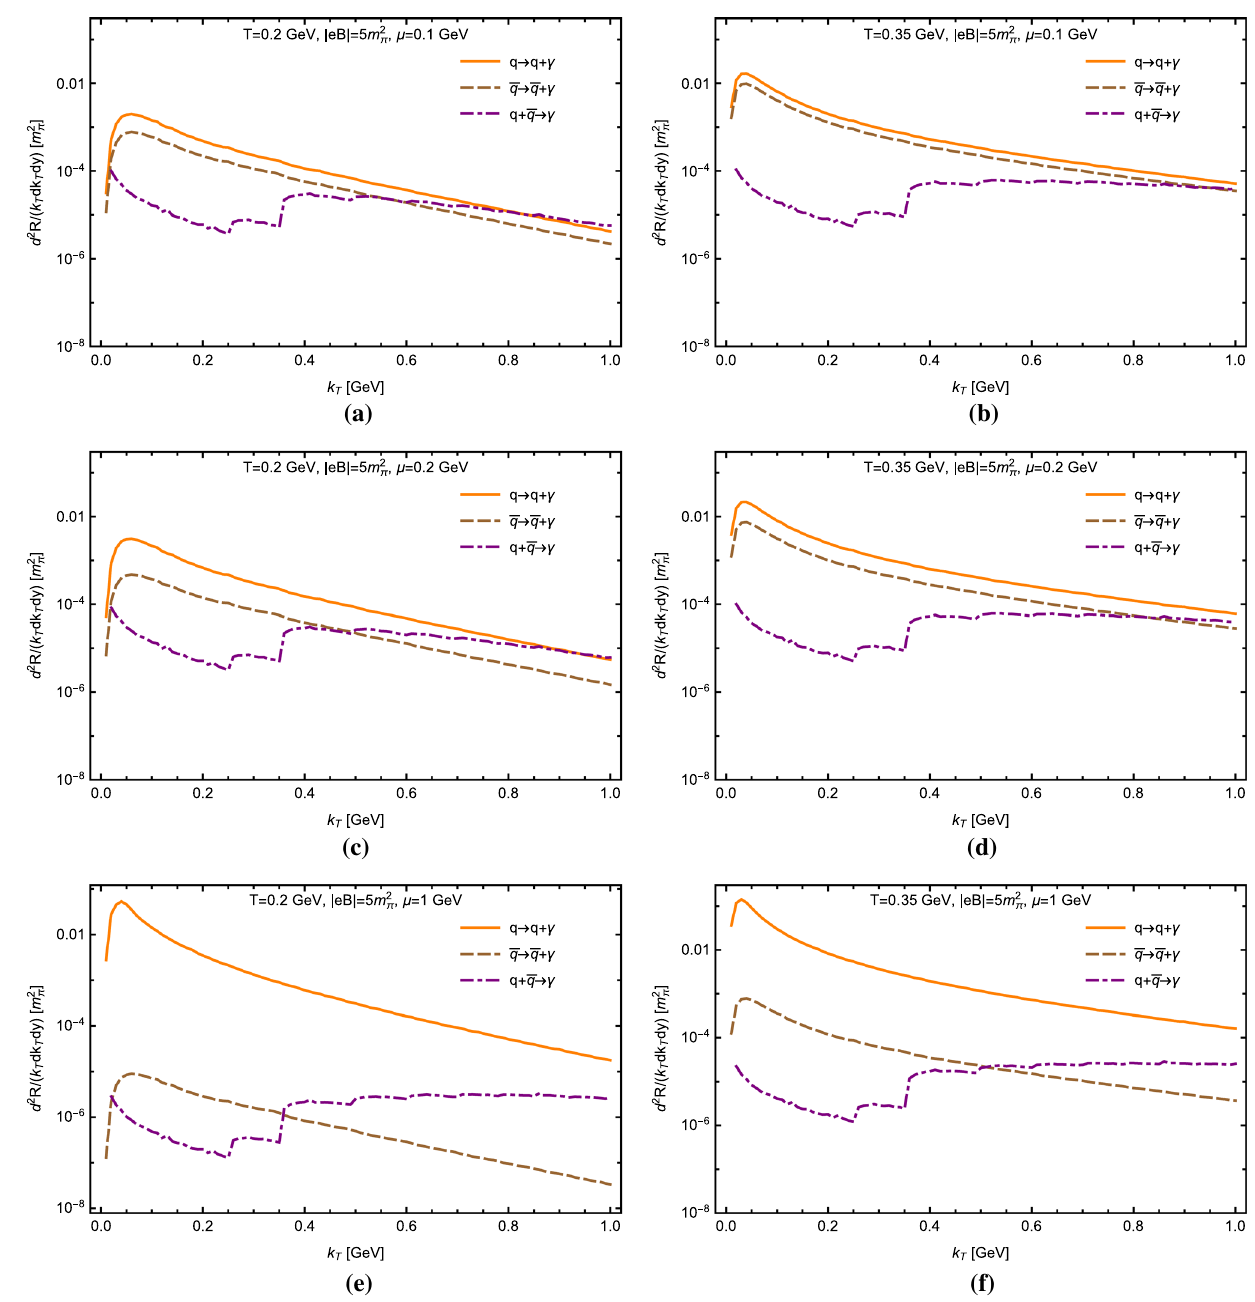
Fig. 4 Partial contributions of different types of processes, i.e., q → q + γ (orange lines), ¯ q → ¯ q + γ (brown dashed lines), and q + ¯ q → γ (purple dot-dashed lines), to the photon production rate at | eB | = 5 m 2 π as a function of the transverse momentum k T . The left panels ( a , c , e )